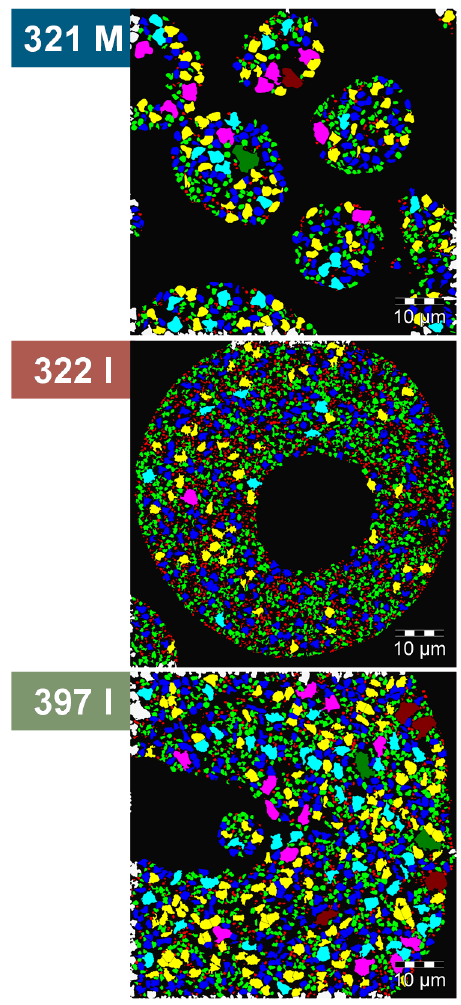
Figure 6. Powder cross-sections (binarized back-scattered electron images, the primary particle size is expressed by the pseudo-colors) of the three investigated LZ powders.